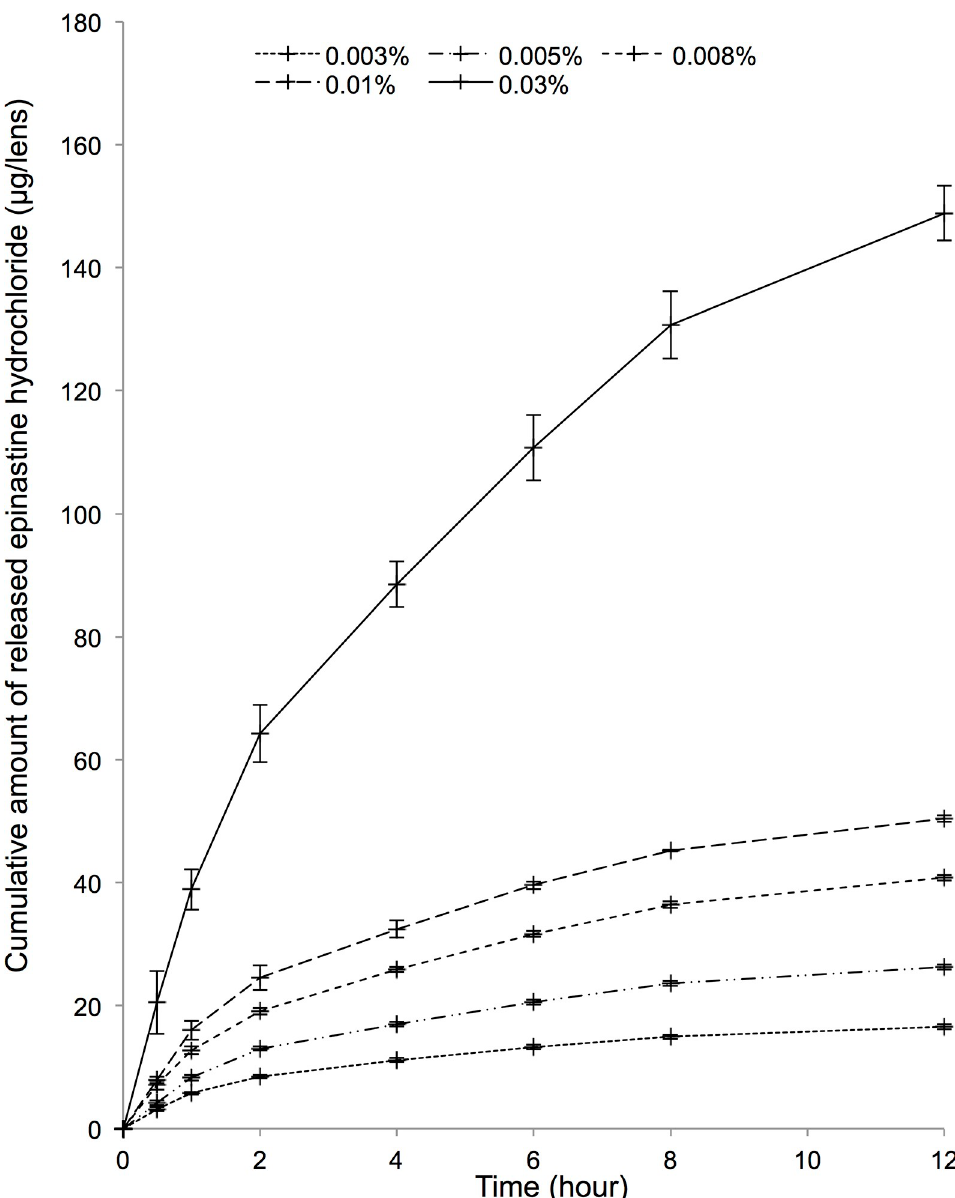
Fig 5. Epinastine hydrochloride (EH) releasing profiles with different EH concentrations. The amount of EH release increased as the concentration of the EH solution used to make the EH-releasing soft contact lenses increased. Regarding the eyes treated with PBS-EDs for 6 h or 12 h (groups B, C, D, and E; right eyes), EB extravasated from the right eyes in groups B and C was not significantly different from each other (P = 0.9998), and also not significantly different from that extravasated from the left eyes in group A (no treatment) ( P = 0.9756, and P = 0.9999, respectively); EB extravasated from the right eyes in groups D and E was not significantly different from each other (P = 0.9014), and less than that from the left eyes in group A (no treatment) ( P < 0.0001 for both). Comparing the eyes treated with EH for 6 h and 12 h, more EB extravasation was observed from the eyes treated with EB-EDs for 12 h (group C, left) than those treated with EB-EDs for